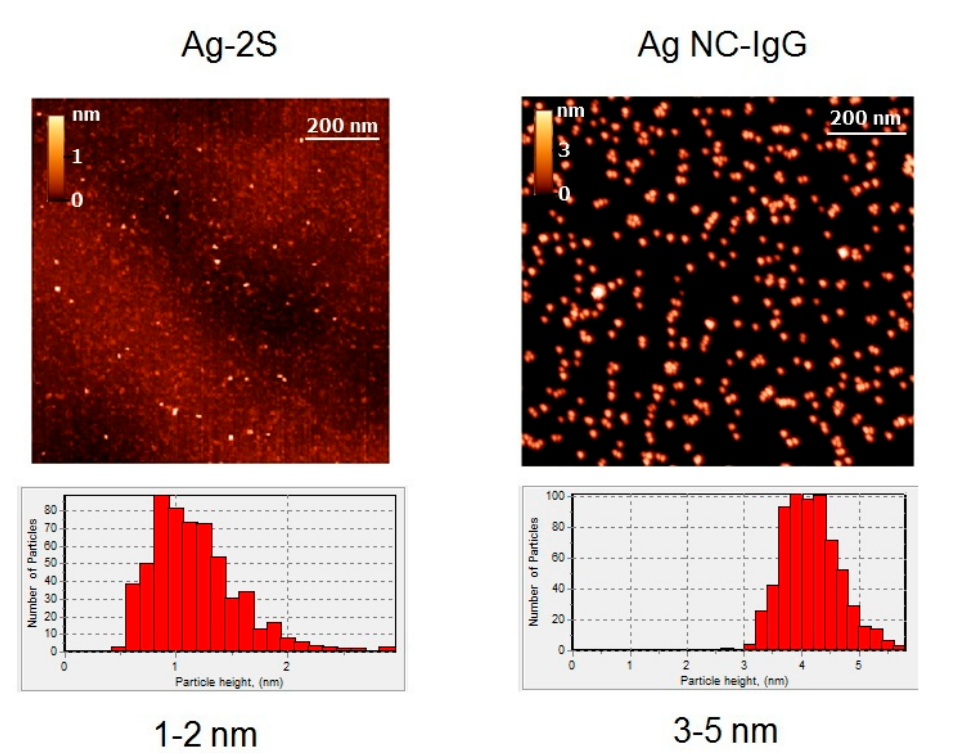
Figure 2. AFM images and height distribution histograms of Ag-2S and Ag NC with